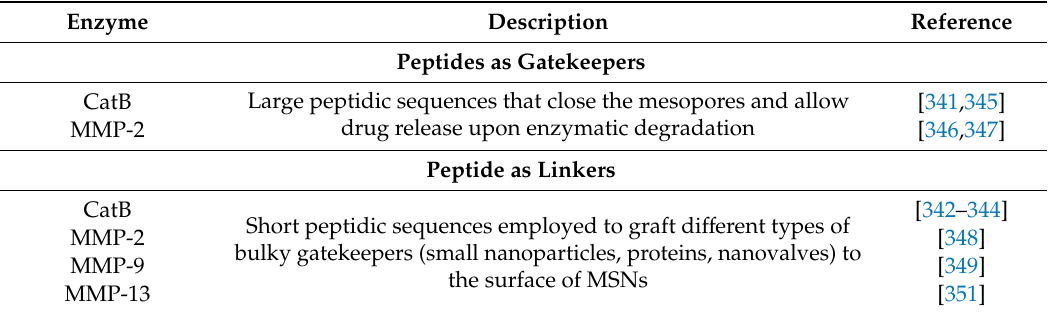
Table 4. Strategies implemented into MSNs for achieving enzyme-responsive drug